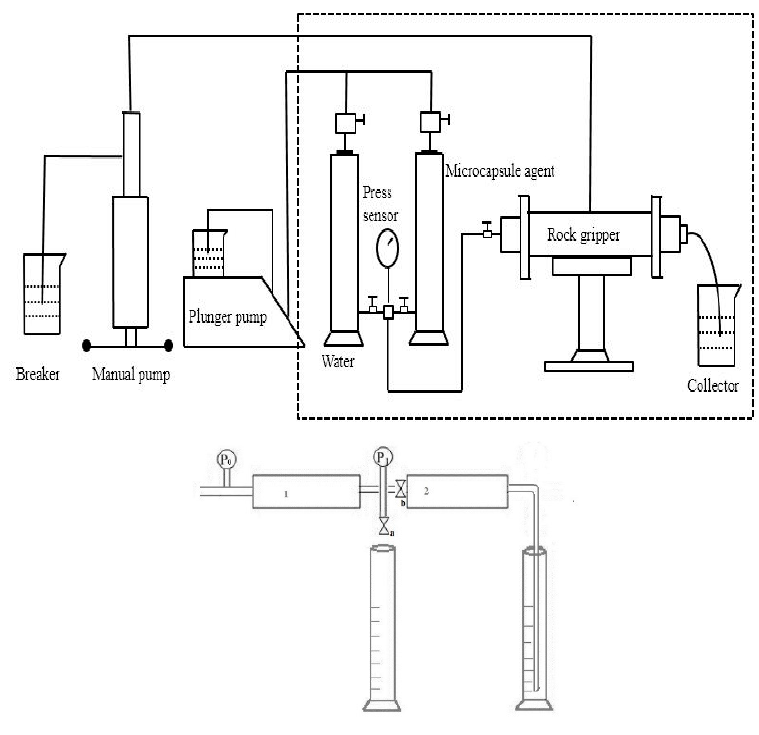
Figure 5. Diagram of series cores.